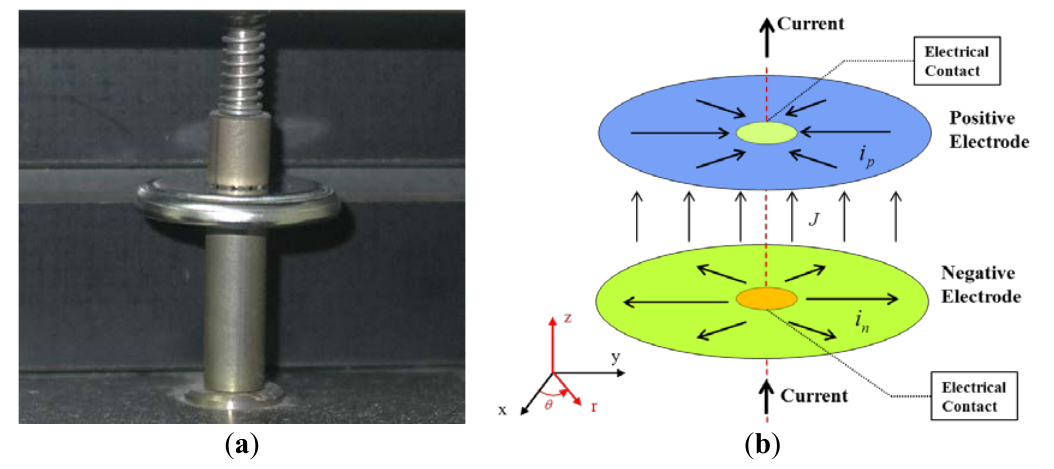
Figure 1. ( a ) Photograph of the coin cell mounted on the jig; and ( b ) schematic diagram of the currents in the two parallel circular electrodes during